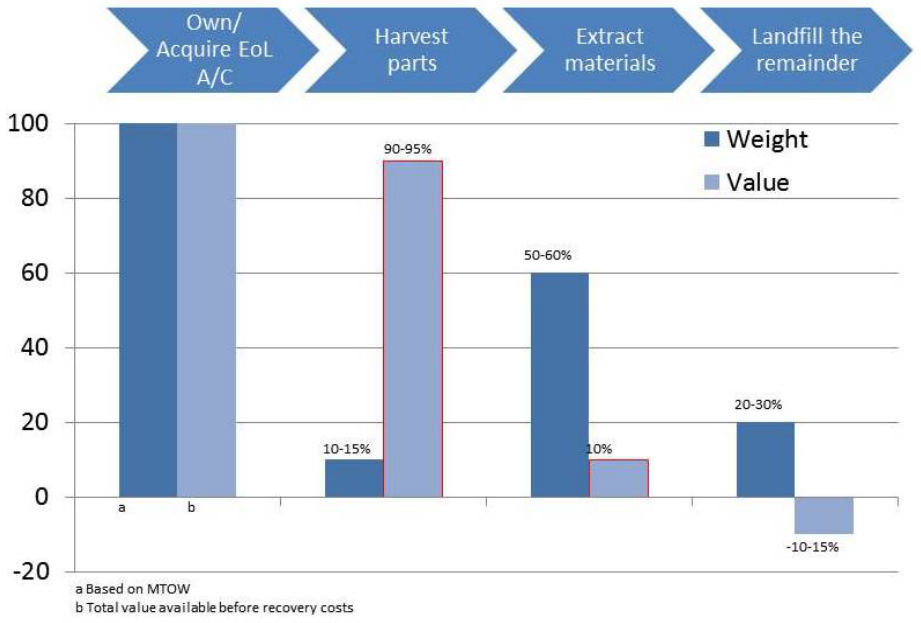
Figure 2. End of life aircraft value and mass distribution estimation [2]. a: Based on maximum take-off weight (MTOW); b: Total value available before recovery costs.